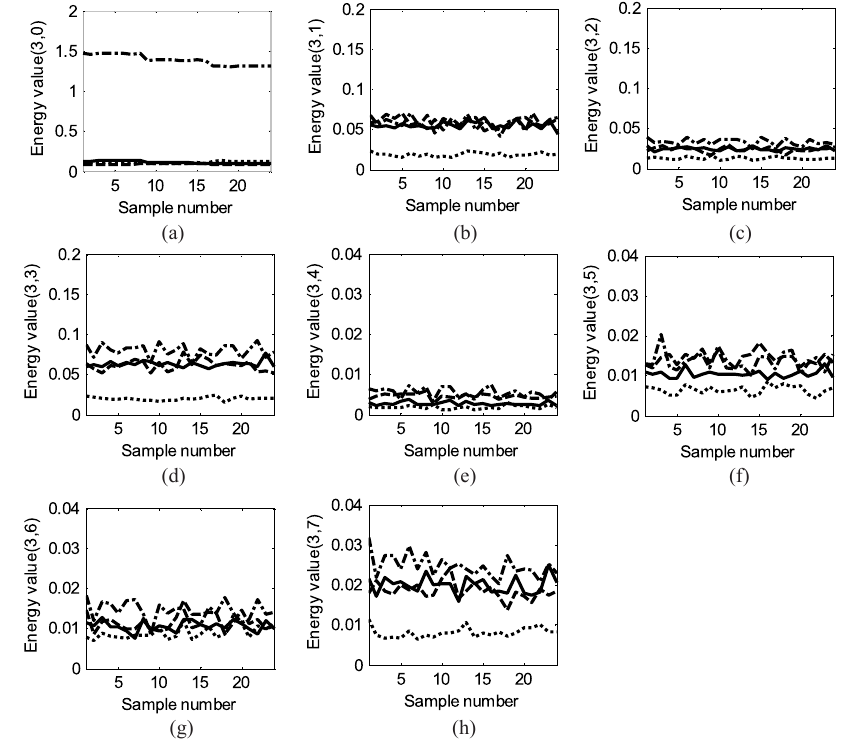
Fig. 10. The energy feature values of the eight reconstructed vibration signals in three-level decomposition of WPA under F 1 (solid), F 2 (dash), F 3 (dot) and F 4 (dash-dot) gear condition.